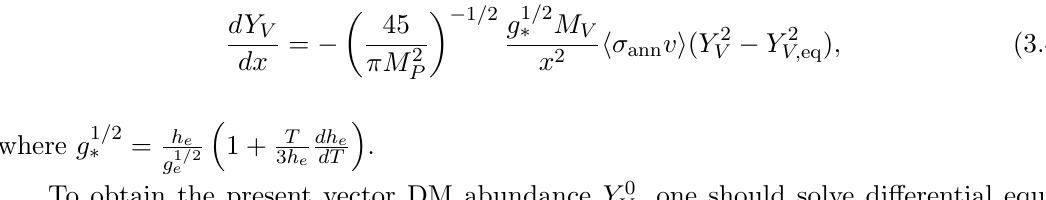
degrees of freedom for the energy density and entropy density, respectively.